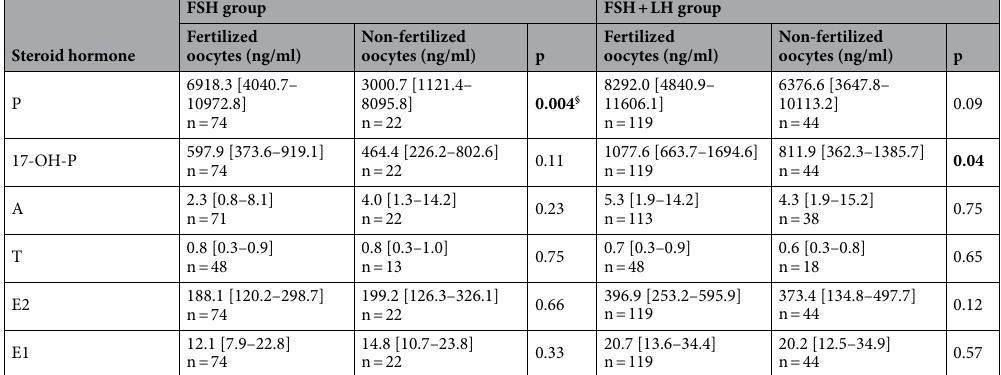
Table 5. Median values [IQR] of Progesterone (P), 17α-Hydroxyprogesterone (17-OH-P), Androstenedione (A), Testosterone (T), Estradiol (E2) and Estrone (E1) levels in FF in the two groups based on fertilization: fertilized and non-fertilized oocytes. Data were distinguished between the two groups of ovarian stimulation (FSH and FSH + LH). p columns indicate the statistical significance between the groups of fertilized and non-fertilized oocytes. In bold statistically significant differences. § Statistical significance was maintained after adjustment for female age and male factor.